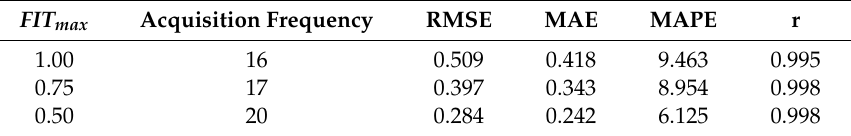
Table 1. Different FIT max , acquisition frequency and error.